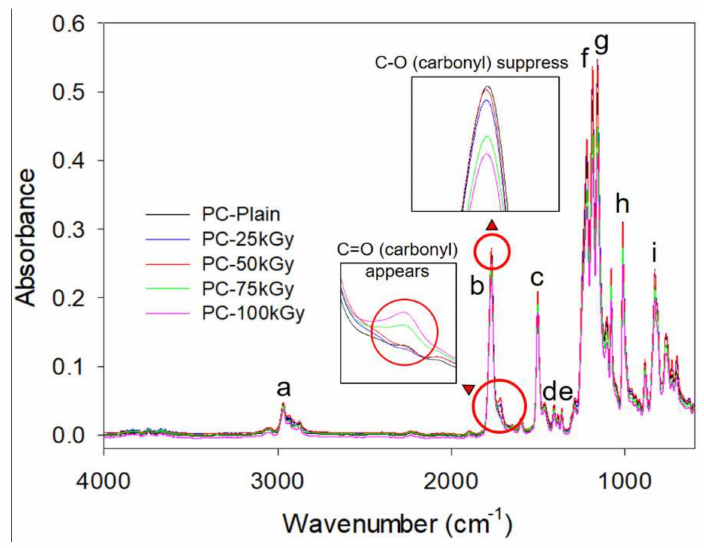
Figure 16. FT-IR spectra of polycarbonate (PC) aggregate with different irradiation doses.